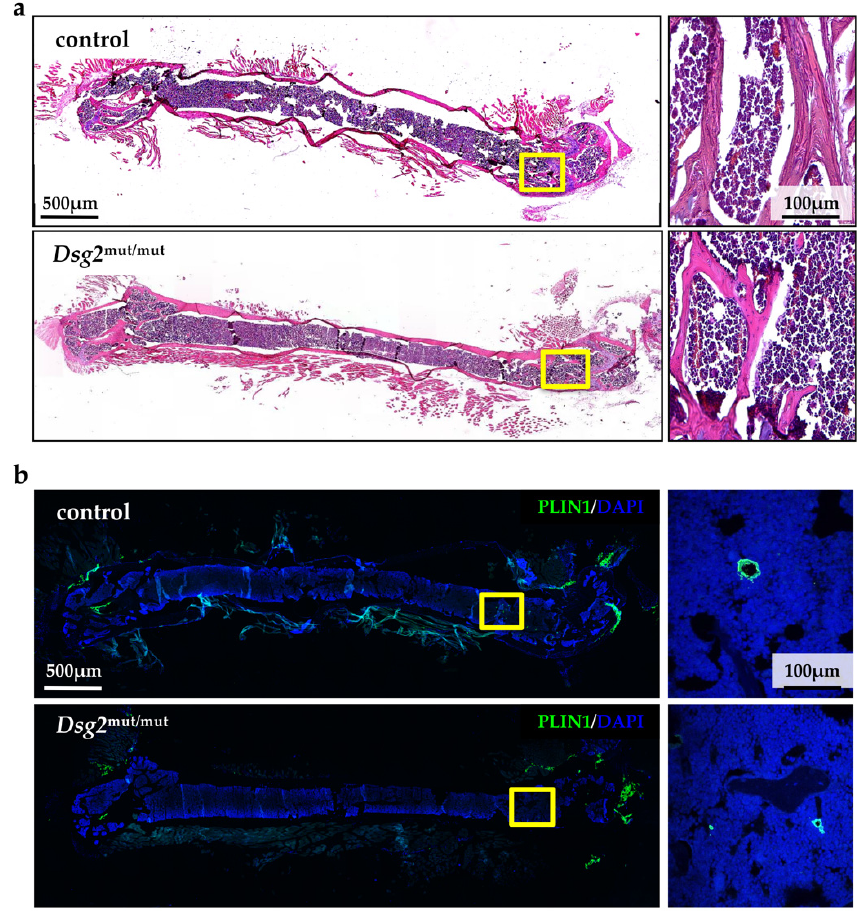
Figure 8. AC-linked Dsg2 variant does not alter bone marrow structure. ( a ) Hematoxylin-eosin staining of femur BM sections from adult control (top panel) and Dsg2 mut/mut (bottom panel) mice. The right panels are high magnifications of the yellow boxes in the left ones. ( b ) IF analysis of femur BM sections from adult control (top panel) and Dsg2 mut/mut (bottom panel) mice, stained with an antibody to perilipin-1 (PLIN1). Nuclei were counterstained with DAPI. The right panels are high magnifications of the yellow boxes in the left ones.